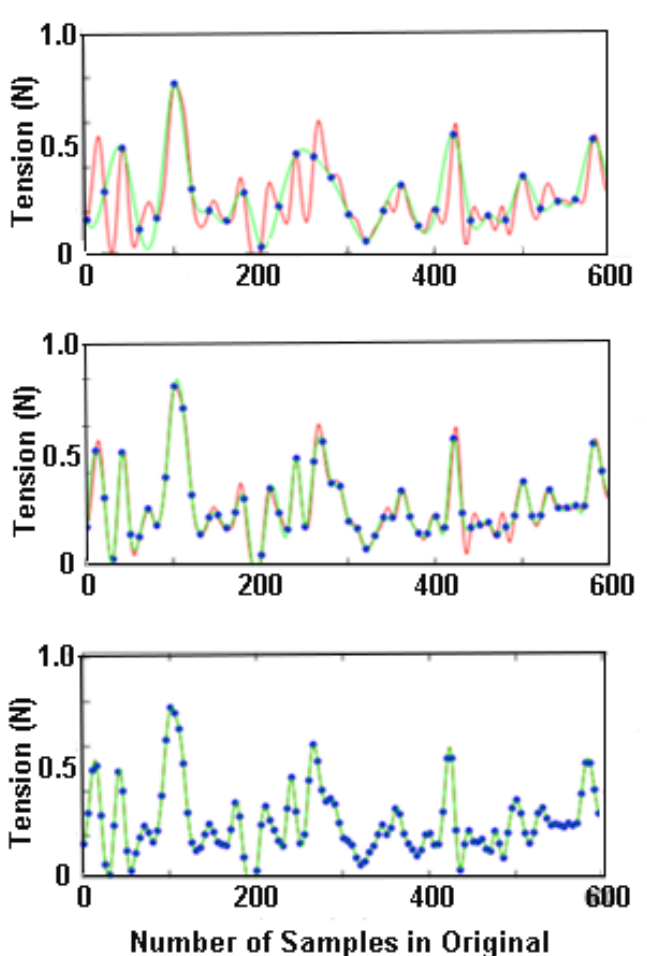
Figure 4. Rein tension curve from a horse trotting with loose reins originally sampled at 240 Hz (red lines). The blue dots represent the data points for each sampling rate (12, 24, 48 Hz) and the green lines are the reconstructed curves after down-sampling to 12 Hz (upper graph), 24 Hz (middle graph), and 48 Hz (lower graph) and then up-sampling to the original sampling rate. The signal is not well preserved after down-sampling to 12 Hz. At 24 Hz some small peaks and troughs are missed and the values of large peaks tend to be under-estimated. At 48 Hz most features of the original 240 Hz curve are preserved.